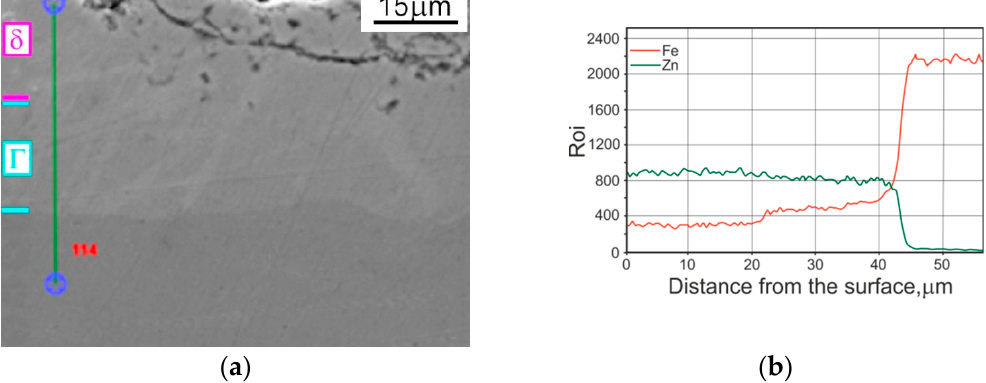
Figure 2. The microstructure observed at the cross section of the TD zinc coating deposited on disc-shaped samples: ( a ) SEM; ( b ) linear EDS analysis. Table 2. The results of EDS analysis of the TD coating deposited on disc-shaped sample. Distance from the Coating Surface, µ m Element